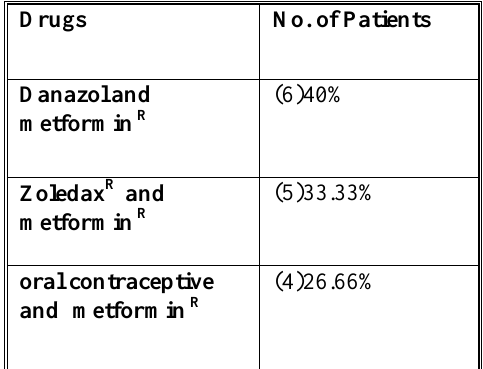
Table (5): Numbers of patients treated with Danazol, zoledax R , and oral contraceptive pills plus metformin(study